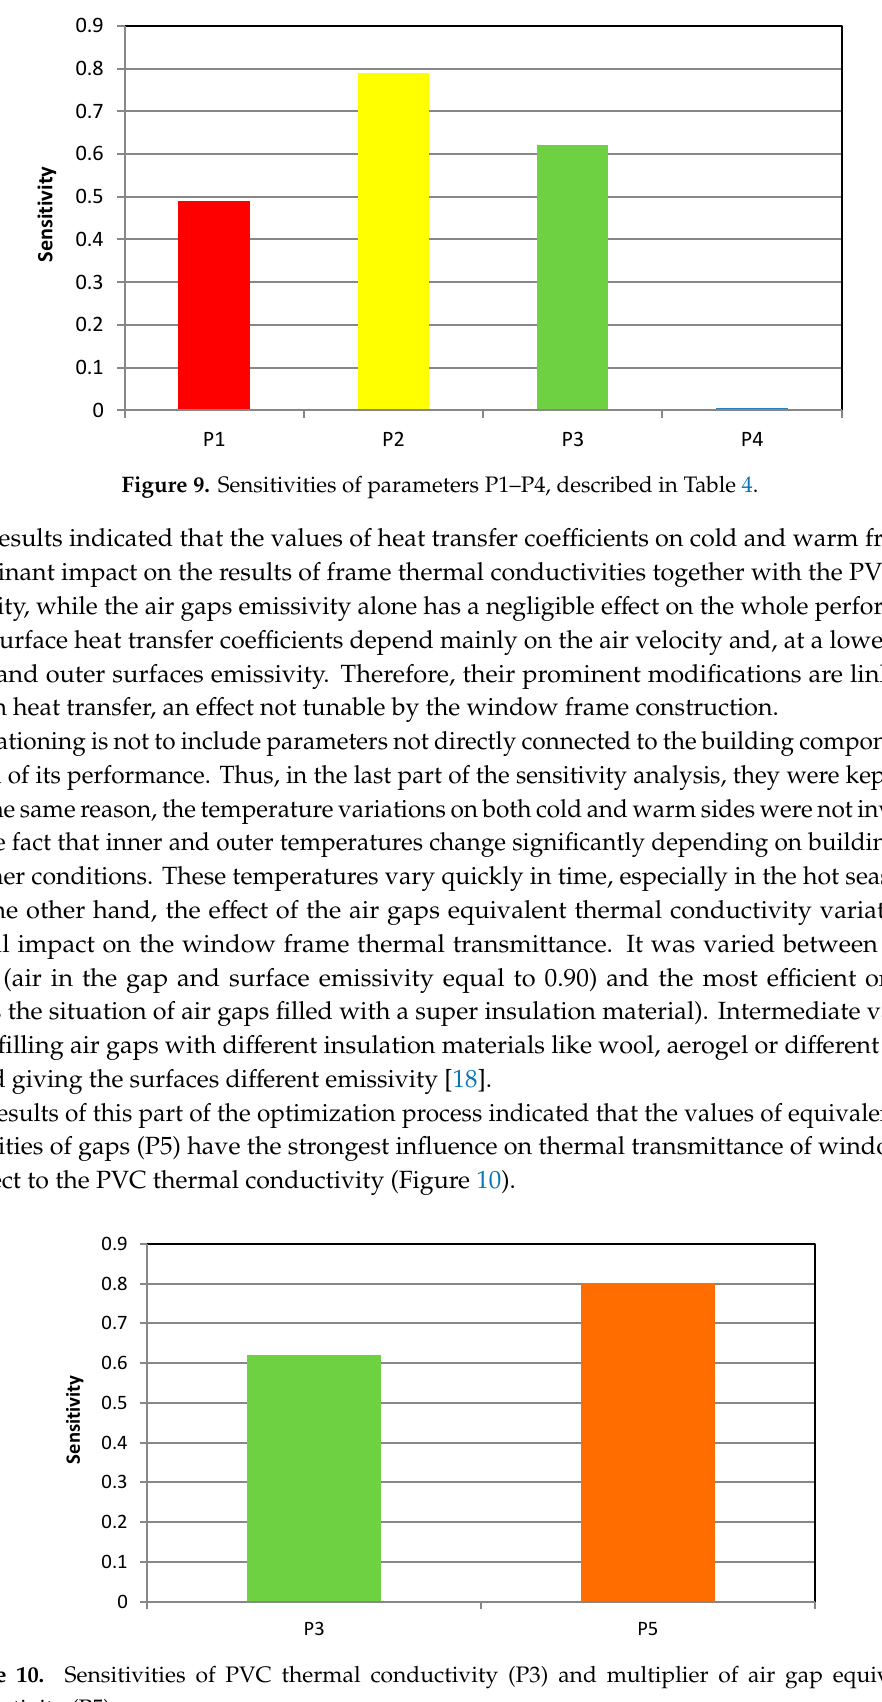
Figure 10. Sensitivities of PVC thermal conductivity (P3) and multiplier of air gap equivalent conductivity (P5).